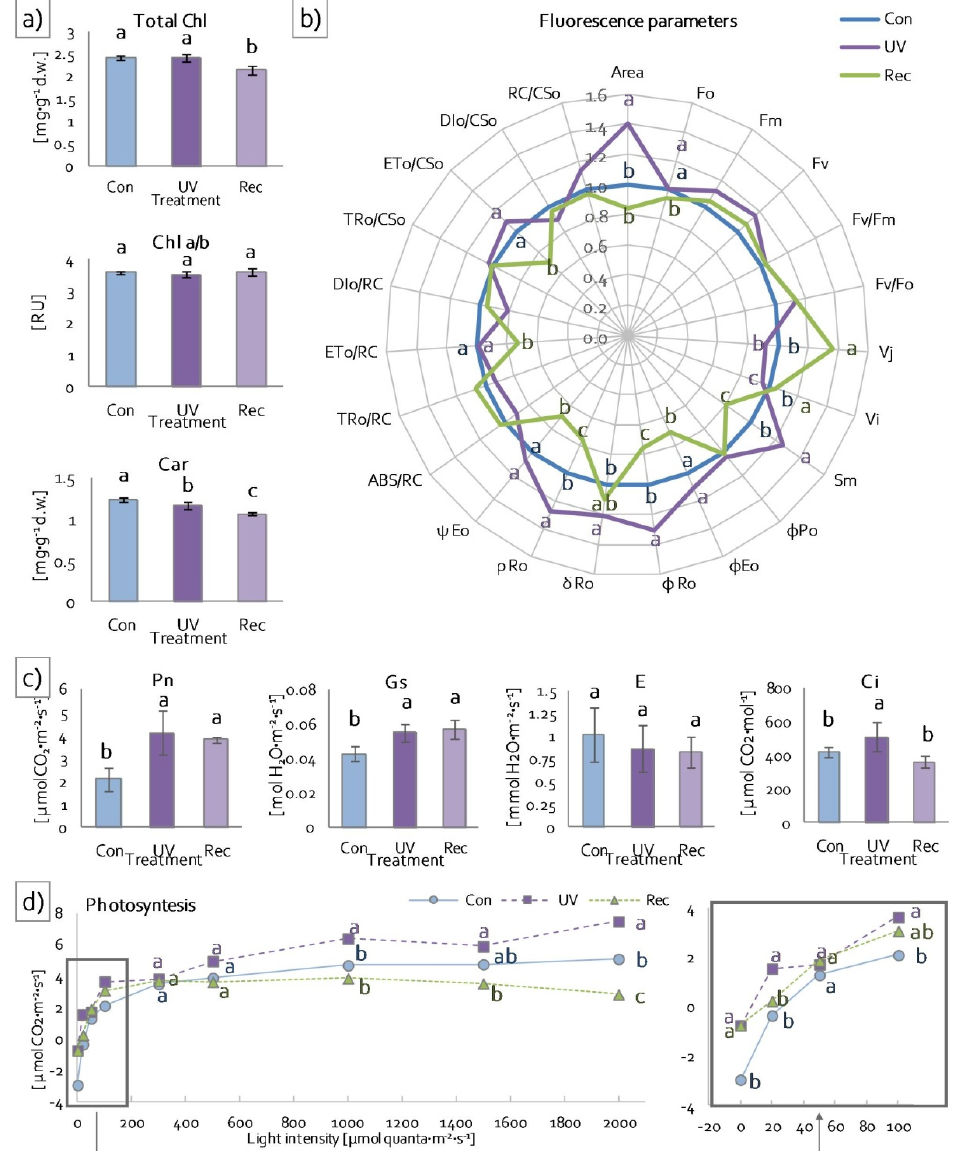
Figure 3. Response of D. muscipula photosynthetic apparatus to UV-A treatment: ( a ) photosynthetic pigment content and ratio ( n = 5); ( b ) structural and functional parameters of photosynthetic apparatus ( n = 10); ( c ) net photosynthesis (Pn), stomatal conductance (Gs), transpiration and intercellular CO 2 concentration (Ci) at 100 μ mol quanta·m − 2 ·s − 1 ( n = 3); ( d ) photosynthesis efficiency ( n = 3); Chl a + b —total chlorophylls, Chl a —chlorophyll a , Chl b —chlorophyll b , Car—carotenoids; Con—control plants; UV—UV plants; Rec—recovery plants; RU—relative units; all of the values in ( b ) are expressed relative to the control (set as 1); abbreviations—see Section 2.3.2.; different letters—statistically significant differences at p ≤ 0.05.